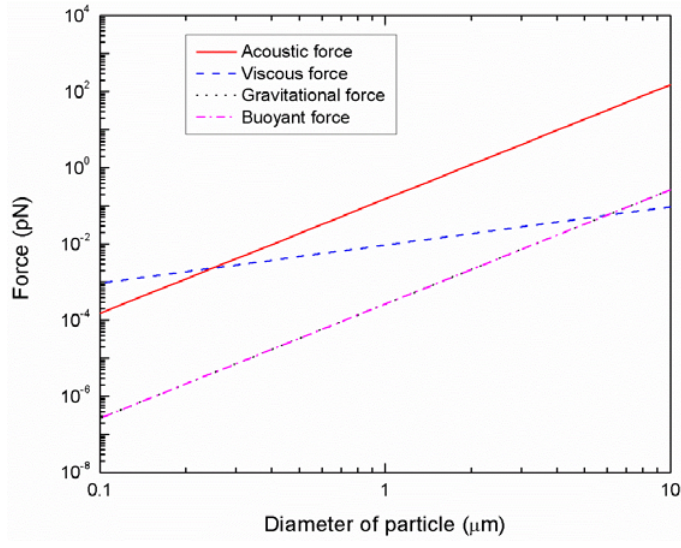
Figure 3. Theoretical analysis of forces acting on particles as a function of particle size.